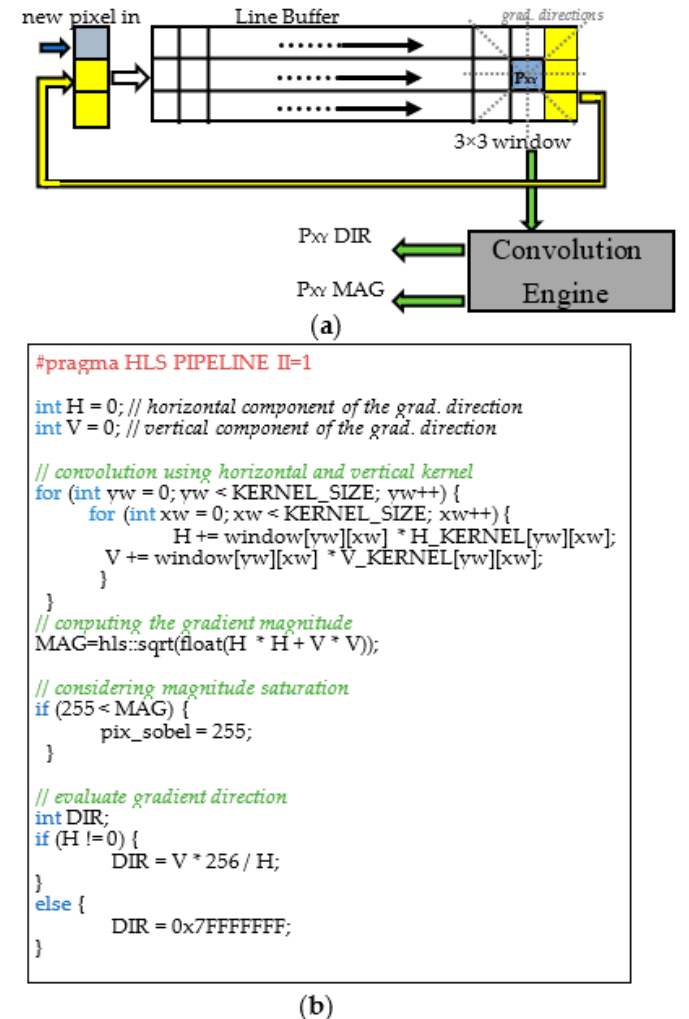
Figure 13. ( a ) The hardware architecture for the gradient calculation; ( b ) excerpt of the C++ HLS code.